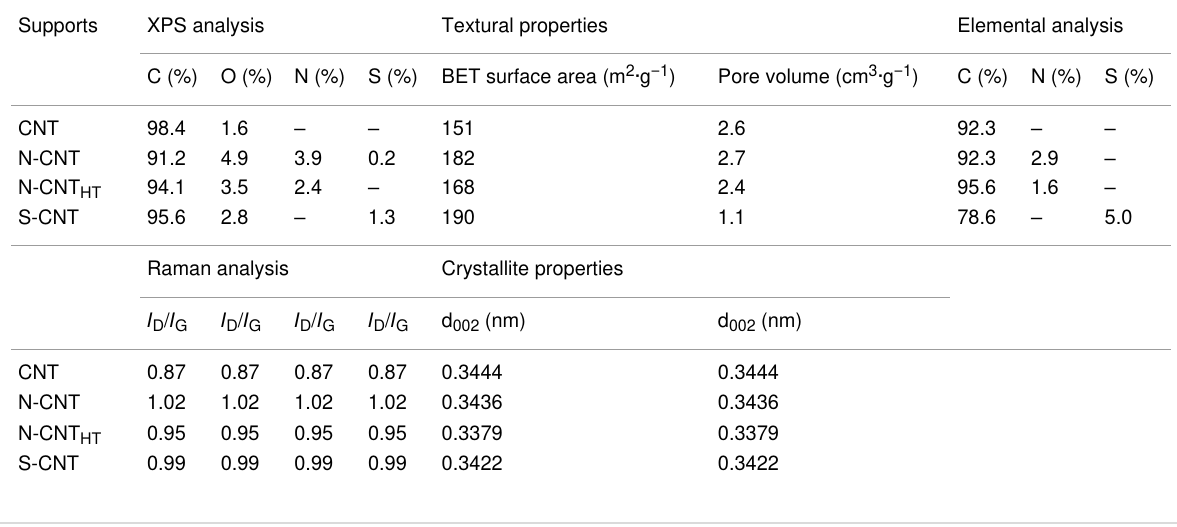
Table 1: Chemical, textural, and crystalline properties of the carbon supports. Supports